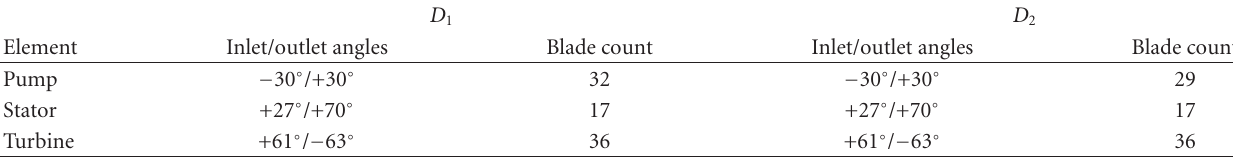
Table 1: Torque converter element design